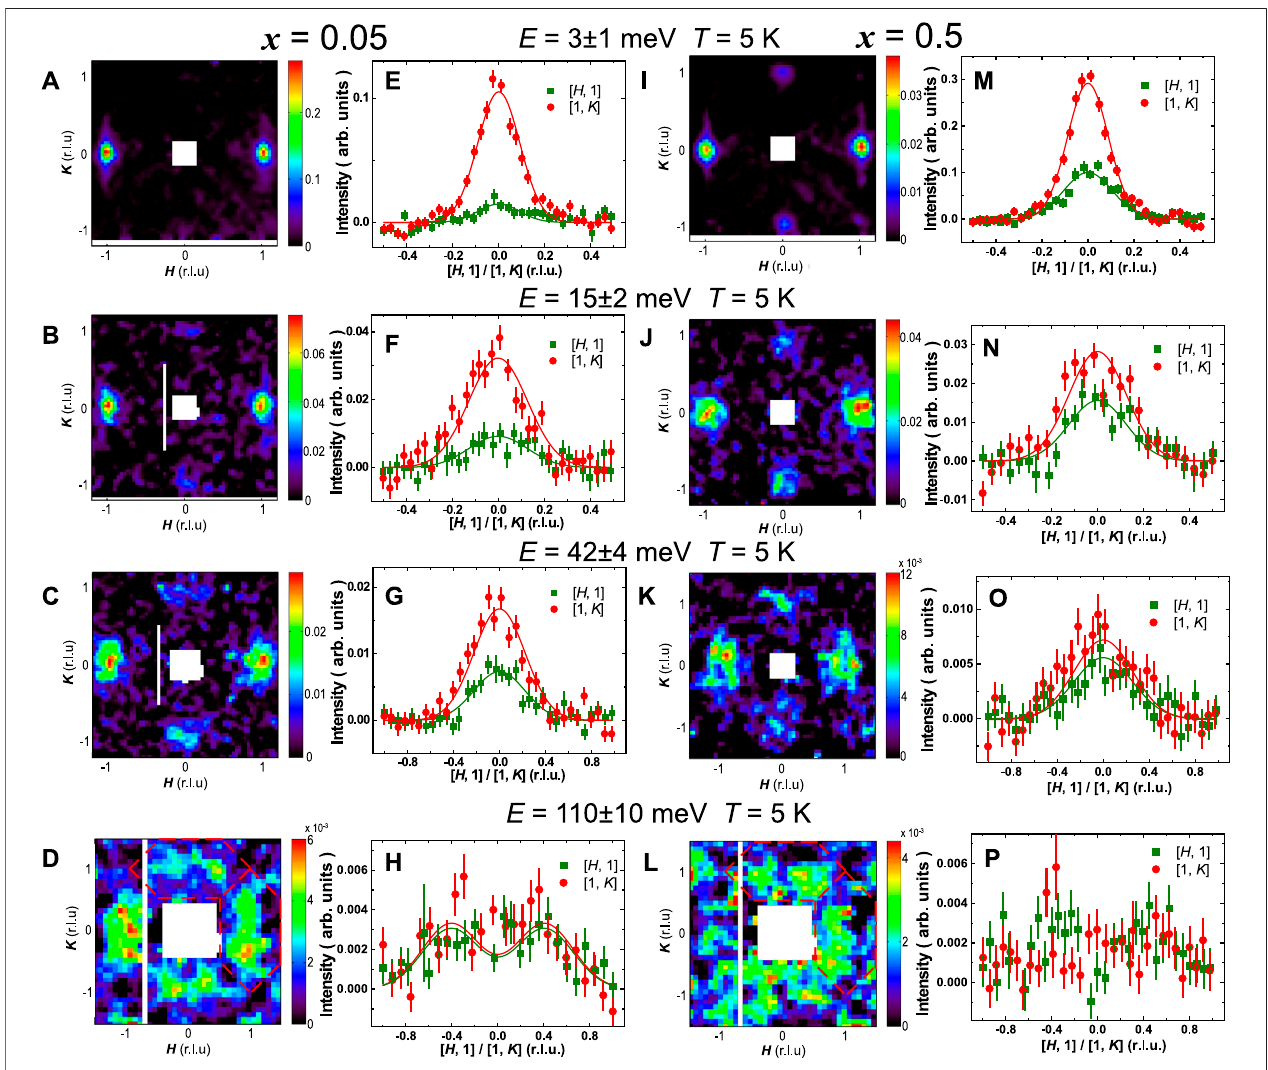
FIGURE 7 | (Color online) Inelastic neutron scattering results on the spin excitations of the uniaxially detwinned samples for x = 0.05 (left) and x = 0.5 (right) compoundsmeasured at T =5 Kbytime-of- fl ightspectrometer4SEASONS.Alldataarepresentedinboth2Dslicesforthe[ H , K ]planeand1Dcutsalong[ H ,0]or[0, K ] at typical energy windows E = 3±1,15±2,42±4,110±10 meV. The solid lines are Gaussian fi ttings guiding for eyes, which are not shown in panel (P) due to poor data quality. The dashed diamonds in panel (D) and (L) illustrate the integrated Brillouin zone for spin excitations around Q = (1,0) and Q = (0,1), respectively.